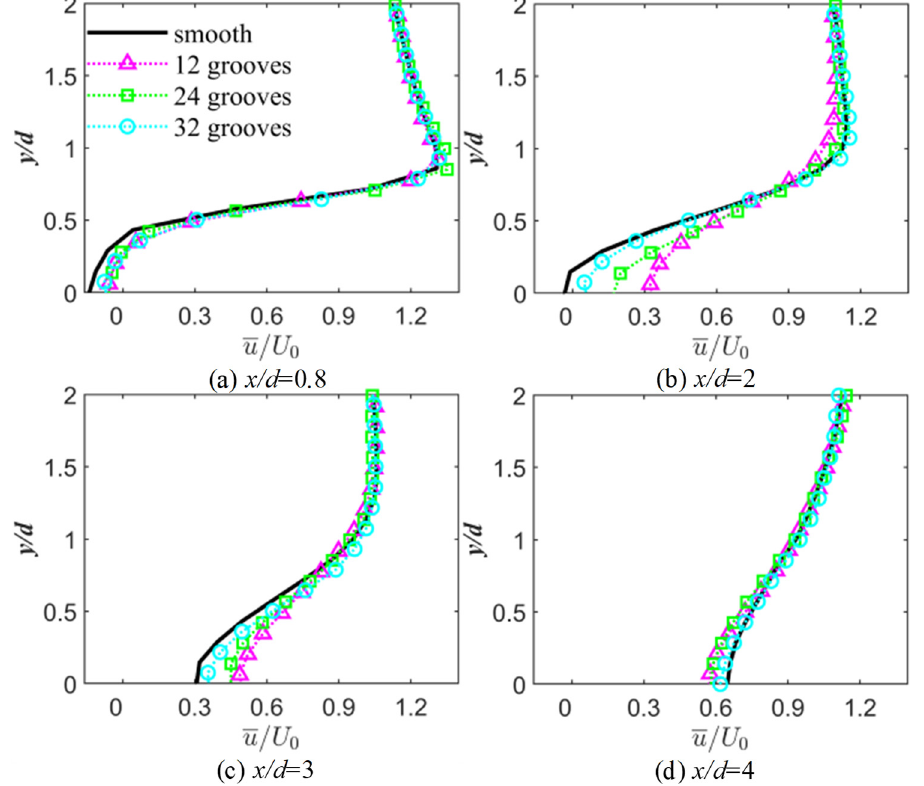
Figure 4. Profiles of time-averaged stream-wise velocities in the ( x, y )-plane.